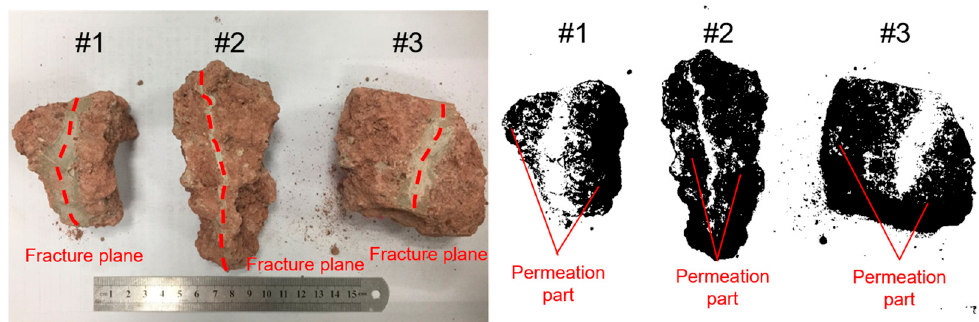
Figure 13. Concretion fragment of Groups #1–3.